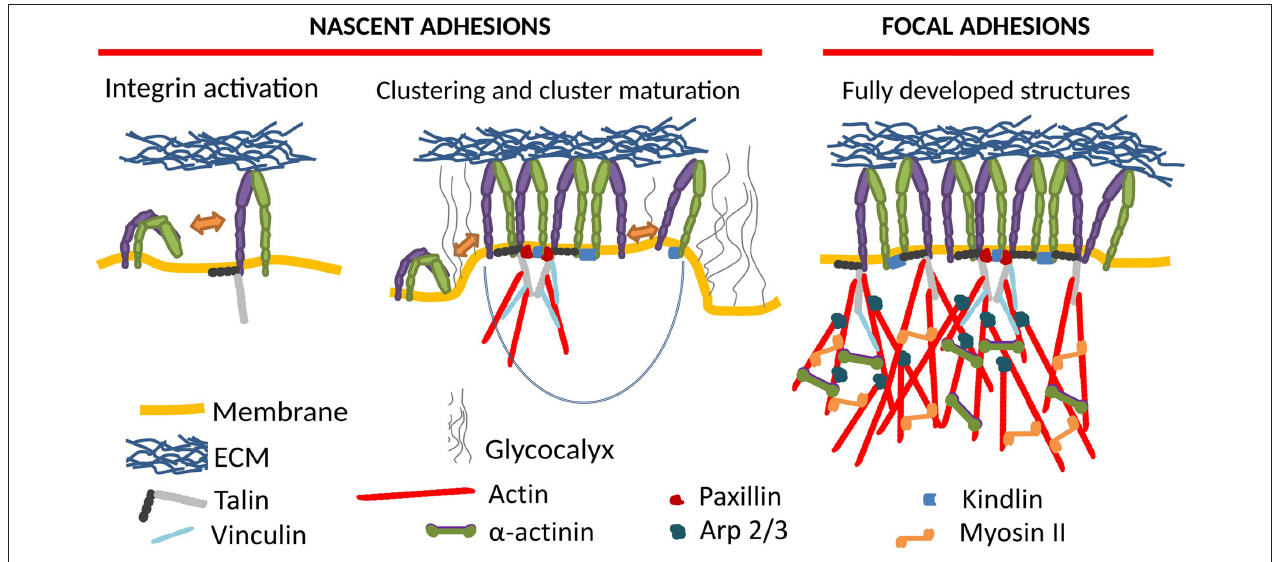
FIGURE 1 | Formation of integrin mediated cell adhesion structures requires integrin activation (left) , which induces macromolecular clustering into nascent adhesions (middle) , which upon maturation grow into focal adhesions (right) . The key molecular players in this process are schematically represented as shown in the